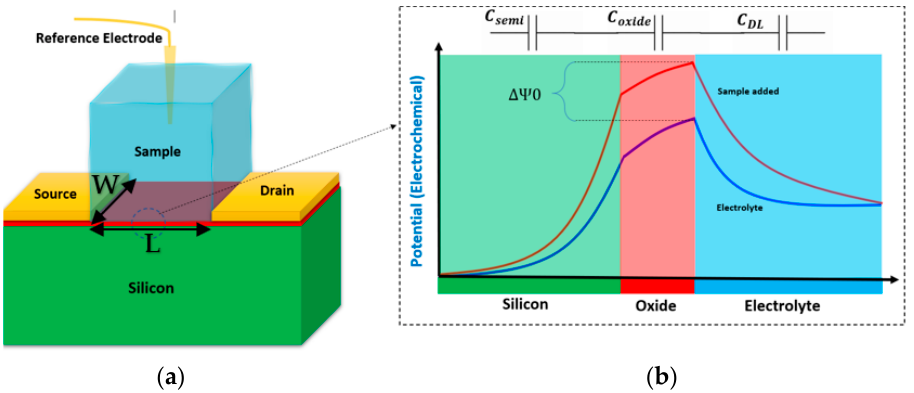
Figure 1. ( a ) The standard structure of a Bio-field-effect transistor (FET); ( b ) the corresponding potential diagram showing the effect of electrolyte on the potential of interfaces. The potential at the oxide layer and solution interface arises then will be decreased gradually to the solution potential. Adding the sample would manipulate this potential curve influencing the charge transport inside the silicon channel. There are three main capacitances involved in the system consisting of the oxide, channel depletion capacitance, and the solution double layer ( C DL ).